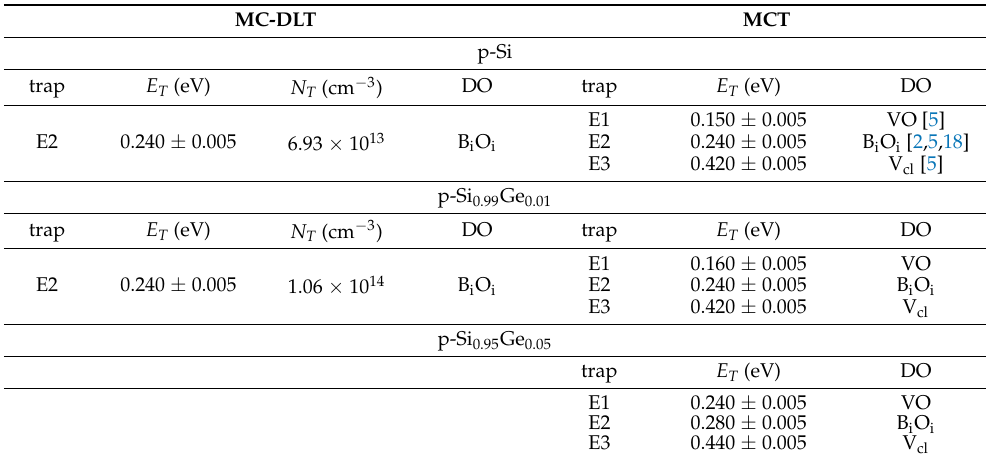
Table 2. The electron traps revealed in the 5.5 MeV electron-irradiated Si, Si 0.99 Ge 0.01 and Si 0.95 Ge 0.05 diodes using MC-DLT and MCT spectra. MC-DLT MCT